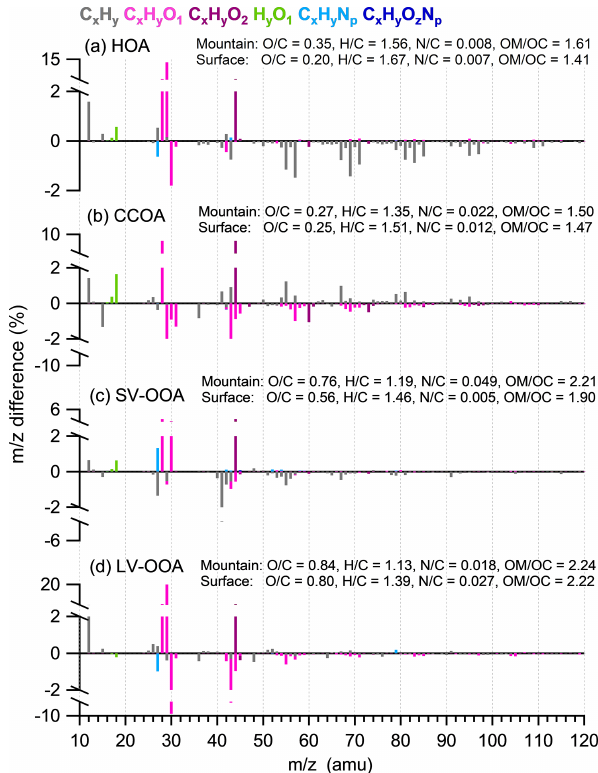
Figure 6. Difference in mass spectra between the mountain and sur- face sites (mountain minus surface) for (a) HOA, (b) CCOA, (c) SV- OOA, and (d)